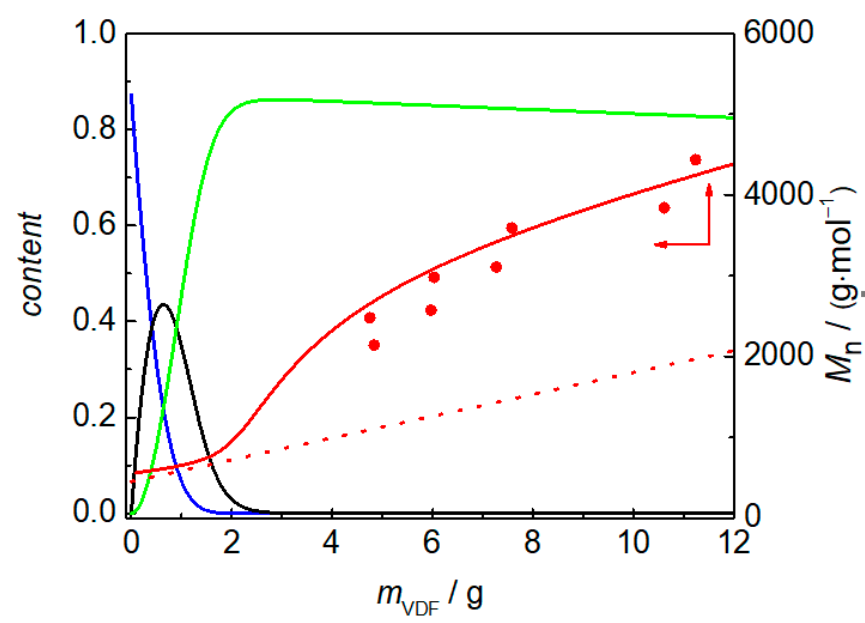
Figure 4. Evolution of the original CTA (blue), the partially transformed CTA (black), fully transformed CTA (green) and number average molar mass (red) during the early stages of the polymerization. The experimental points (red dots) and modelled number average molar masses refer to a reaction at 20 bar with 7.5 mmol I–C 4 F 8 –I (sample 5).